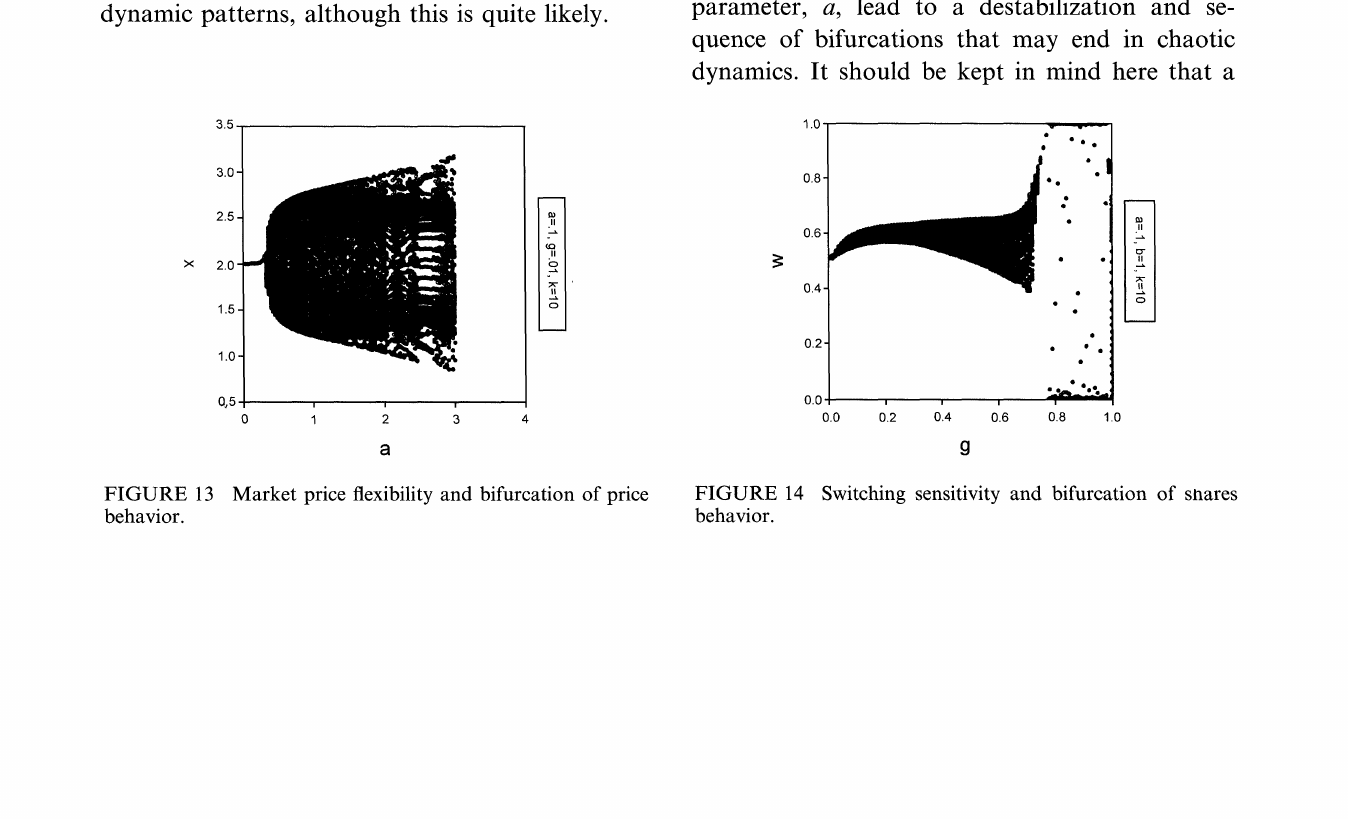
FIGURE 14 Switching sensitivity and bifurcation of snares